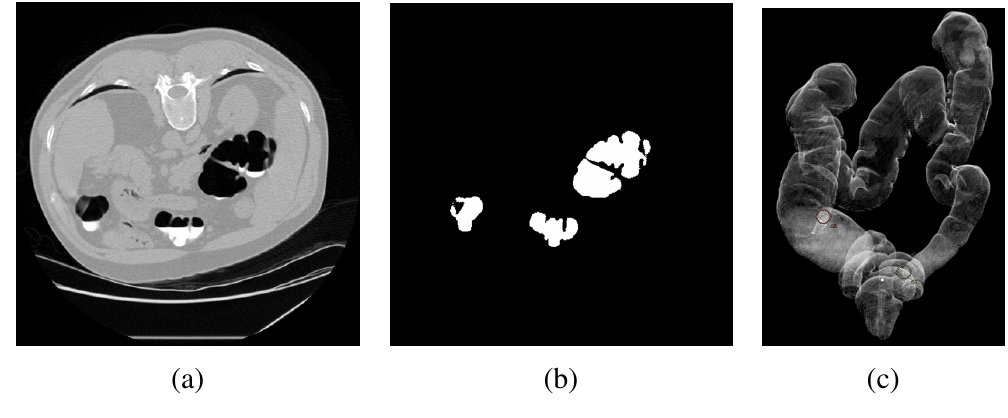
Figure 5. Original slice (a) and colon segmentation after liquid detection and merging (b). Final colon segmentation, with overlaid CAD marks